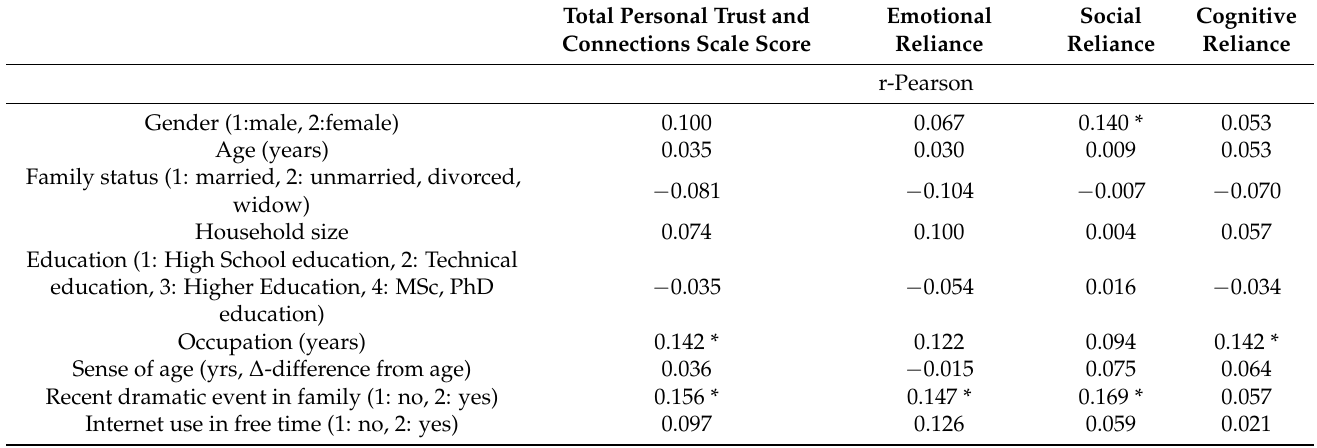
Table 5. Univariate correlations of the ‘Scale of Personal Trust and Connections’ and its components with the characteristics of the 218 study participants.